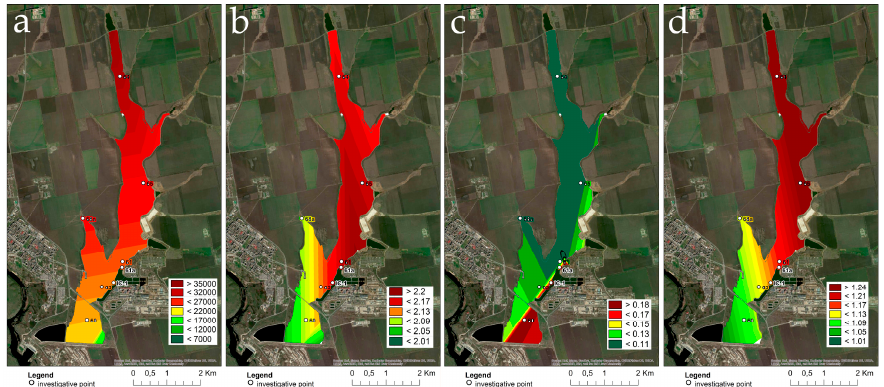
Figure 10. Combined statistical and landscape maps for the Tashlyk reservoir. Abundance ( a ); Index saprobity S ( b ); Ammonia ( c ); Index WESI ( d ). Colors are given for the value amplitude of each mapped variable from green (lower boxes in the legend key) to red (upper boxes in the legend key).